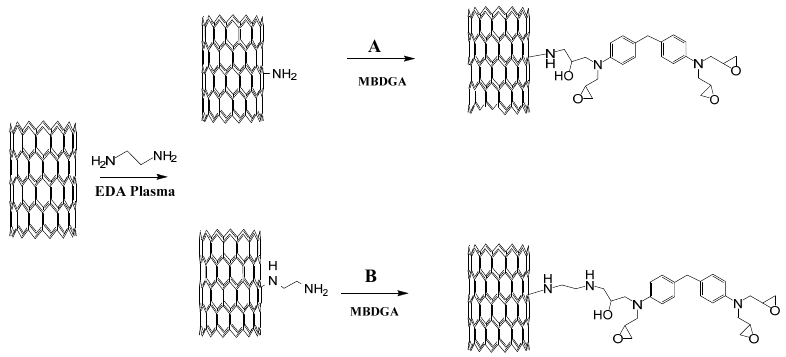
Figure 3. Proposed cross ‐ linking reaction mechanism of EDA functionalized MWCNTs in threads and fibers. Epoxy functional groups in MBDGA are the actives sites that promote covalent bond formation between MWCNTs.